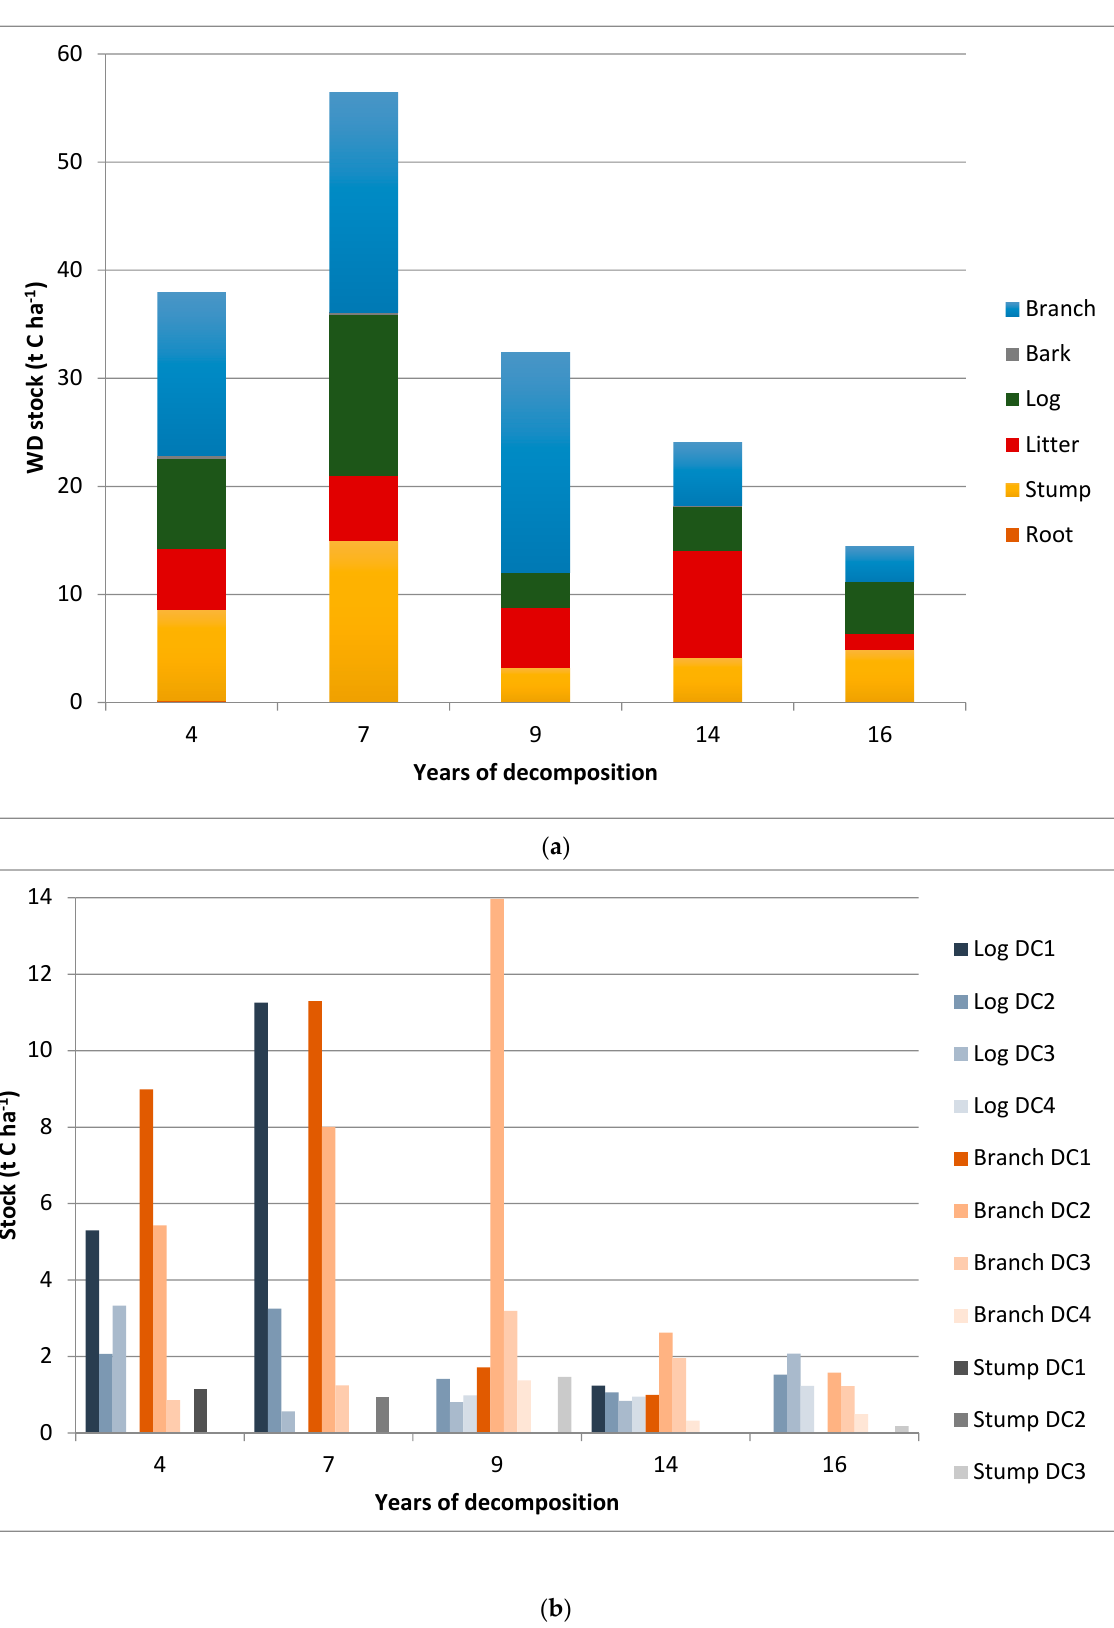
Figure 2. ( a ) C stocks of windrowed woody debris and litter; and ( b ) C stocks of the stump, branch and log categories, per decay class (DC).